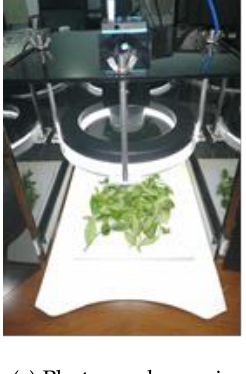
Figure 9. Acquisition of experimental samples.